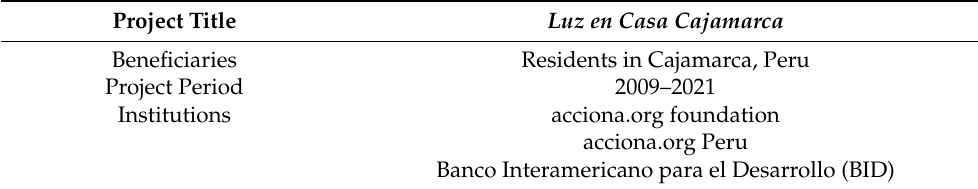
Table 2. “Luz en Casa Cajamarca”: Project